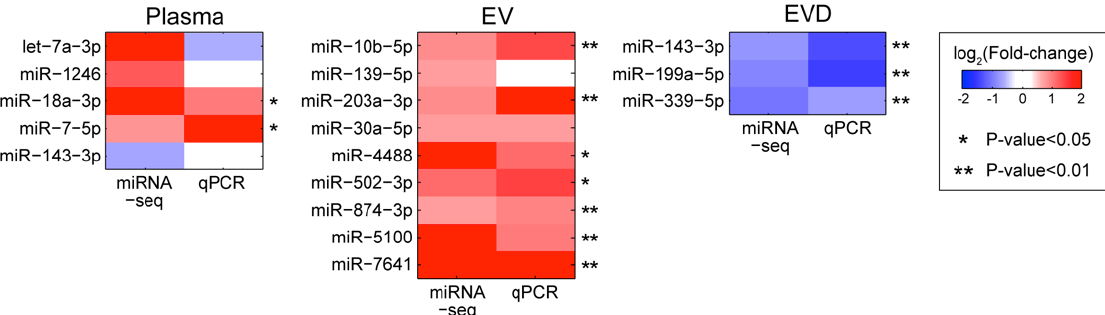
Figure 3. Consistent differential abundances of the miRNAs in qPCR and sequencing platforms in the discovery set. The color gradient indicates the fold changes between the PTSD- and PTSD+ subjects.